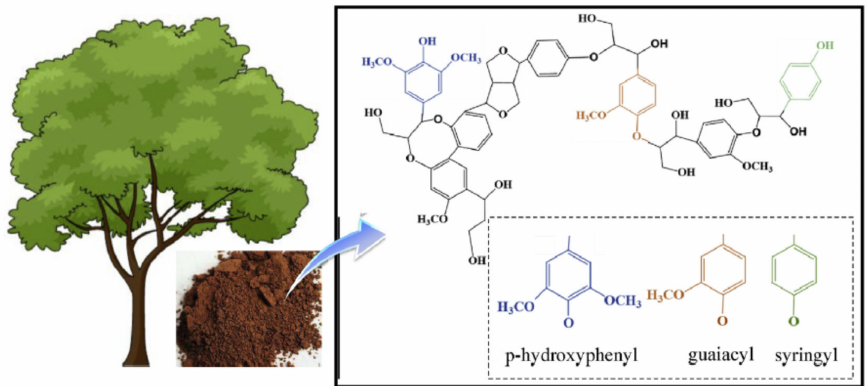
Figure 1. The chemical composition and structure of lignin. Adapted from Ref. [31], with permission from